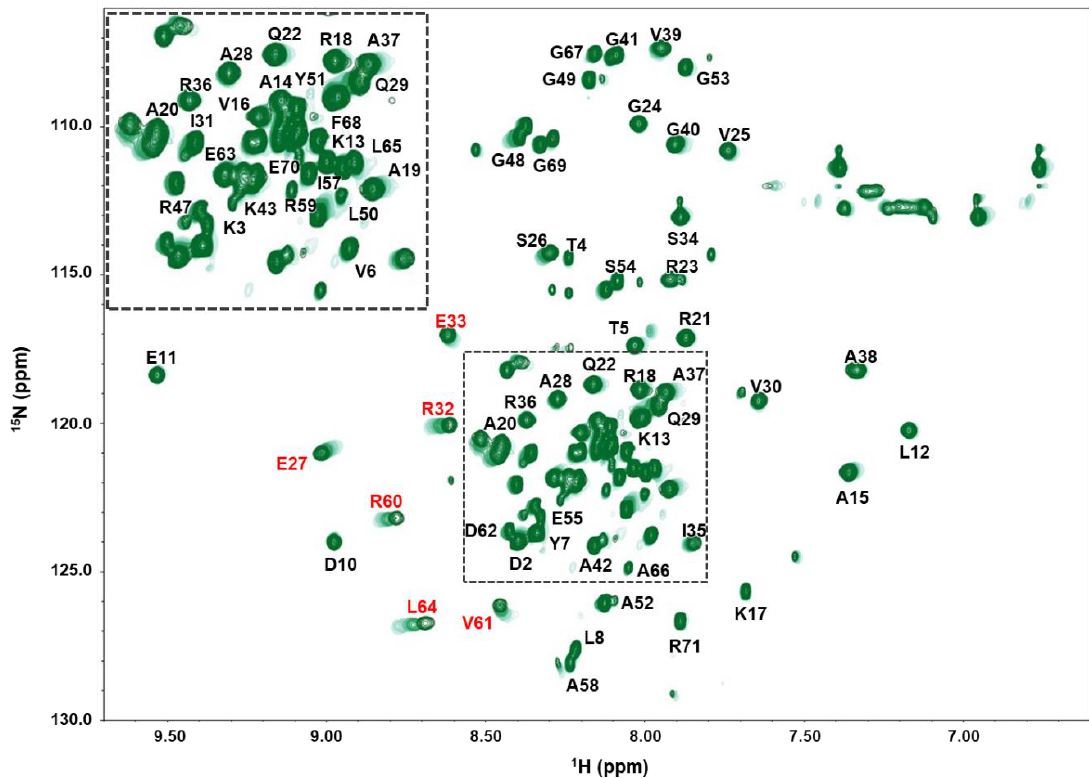
Figure 3. NMR titration of VapB26 with V26-SP-8 . The residues in VapB26 showing notable CSP are marked in red.